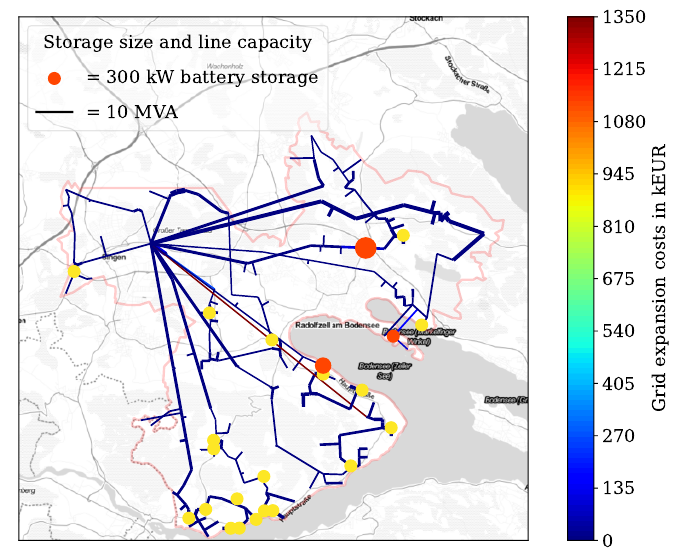
Figure 12. Allocation of grid and storage expansion for a representative MV grid for the scenario eGo 100 . Orange colored nodes represent battery storage units. Color of other nodes and lines represents expansion costs of stations and